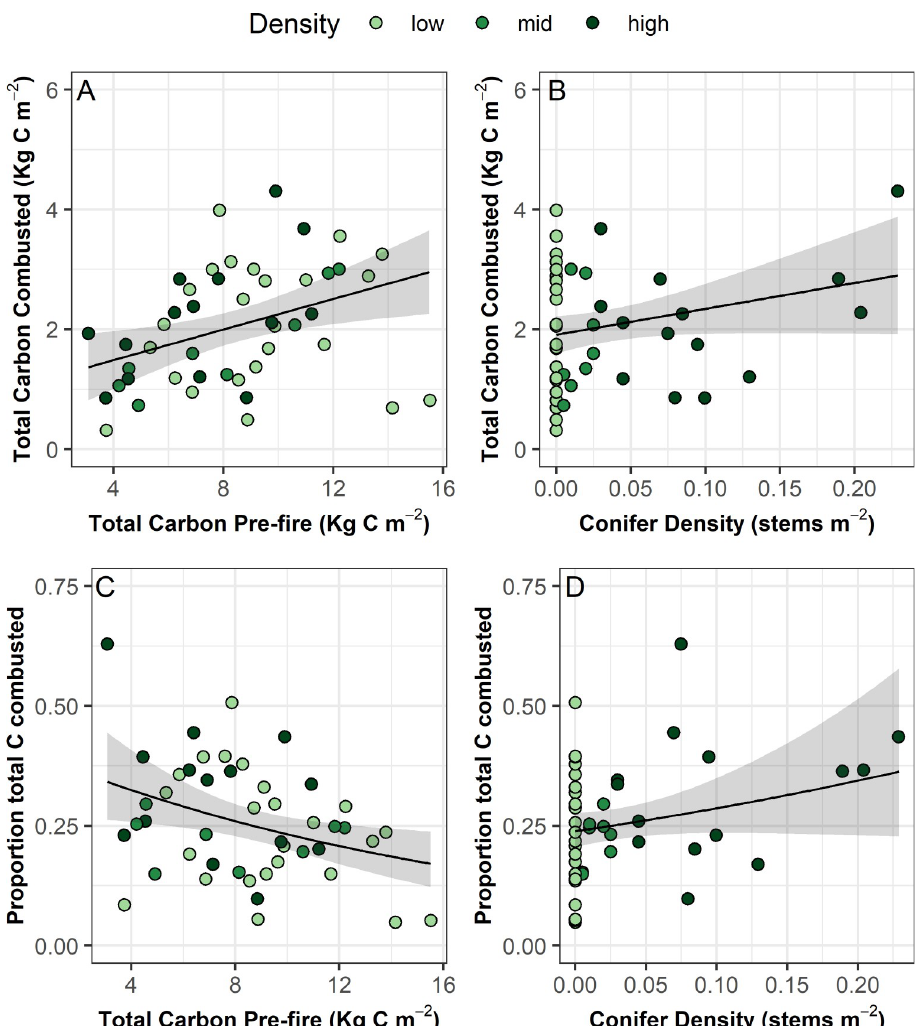
was used to model total C combusted and a generalized linear mixed effect model with a Gamma error distribution and log link function was used to model proportion of total C combusted. Both included a random effect of grid (2 levels). See Table 2 for model